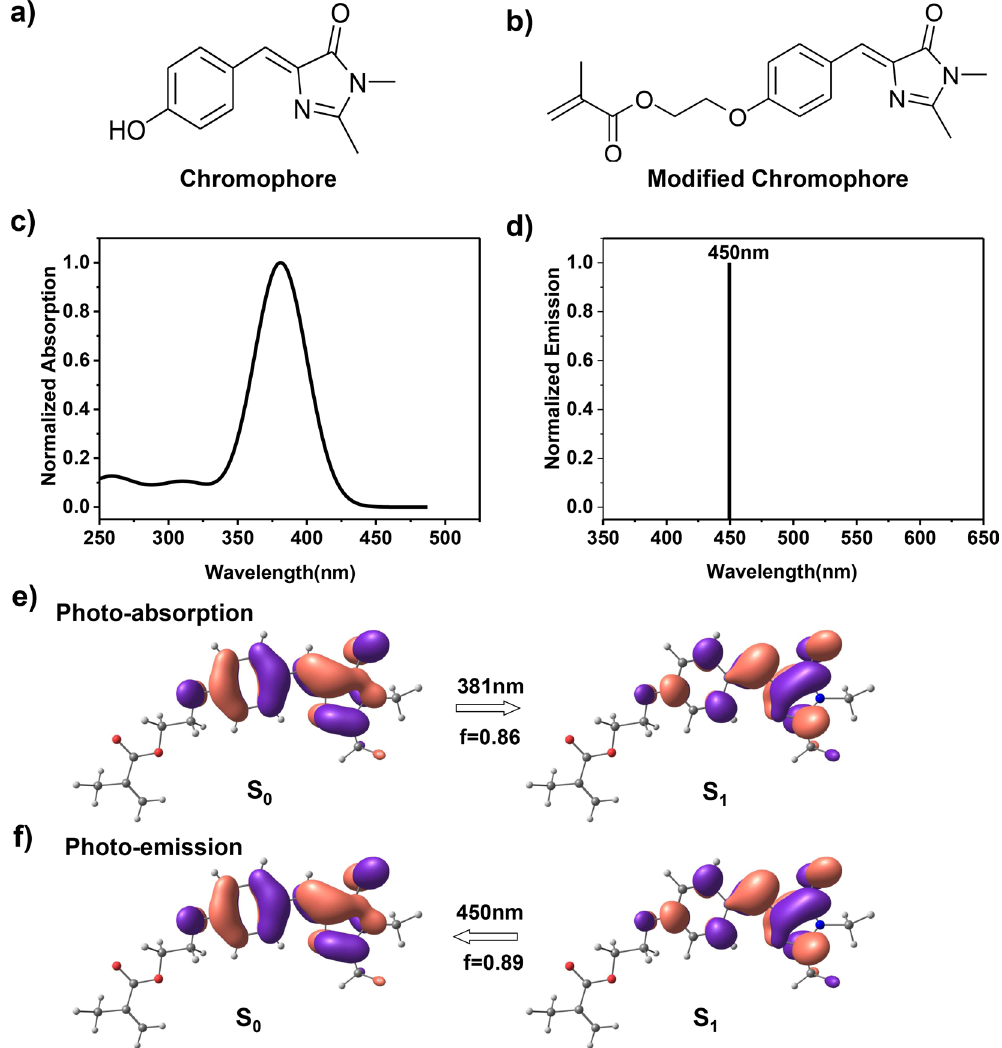
Figure 1. Photo absorption and emission process of the modified GFP chromophore. ( a ) Chemical structures of the GFP chromophore and ( b ) the C = C double bond-modified GFP chromophore. ( c ) The computed absorption spectrum together with the lowest photo-emission peak ( d ) of the modified chromophore. The calculated transitions between frontier orbitals for the photo absorption ( e ) and emission ( f ) of the modified chromophore in aqueous solution. The blue, gray, white and red balls represent N, C, H and O atoms, respectively. f stands for oscillator